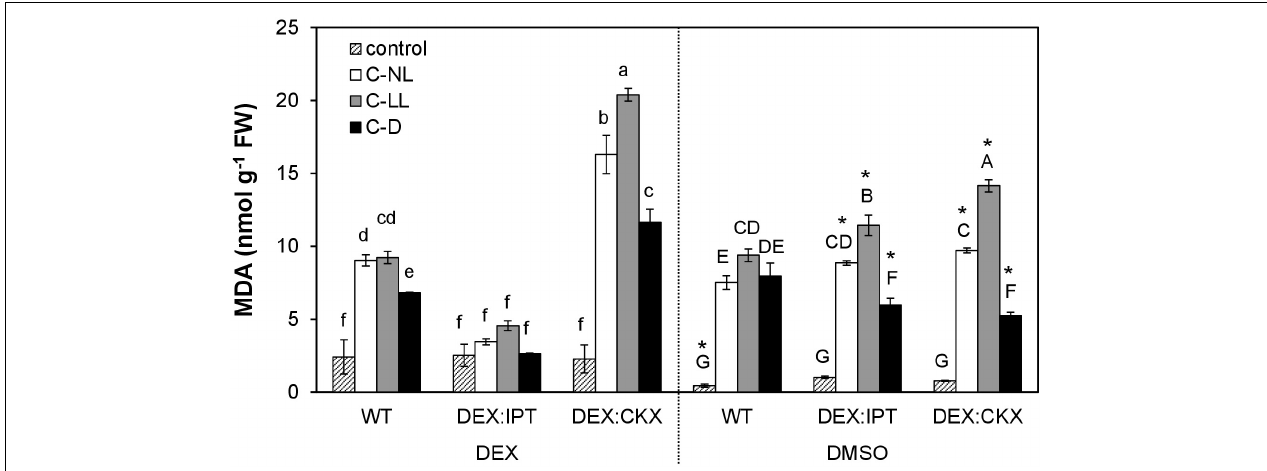
FIGURE 1 | Lipid peroxidation expressed as malondialdehyde (MDA) content in leaves of wild-type (WT) and transformants DEX:IPT and DEX:CKX . See Table 1 for the description of experimental conditions. Plants were either activated with dexamethasone (DEX; diluted in DMSO) or treated with DMSO only. Means ± SD are shown. Biological samples from three independent experiments were analyzed ( n = 3). The differences between DEX and DMSO treatments within each experimental variant were evaluated by Student’s t test (significant differences at p < 0.05 are indicated with an asterisk). The comparison among all experimental variants within the DEX (lowercase letters) or DMSO (capital letters) treatments was evaluated by one-way ANOVA with Tukey’s post hoc test ( p <